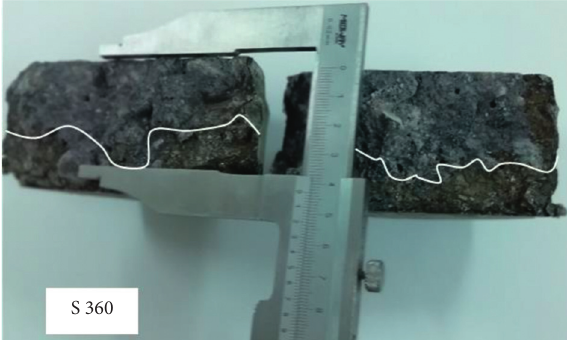
Figure 9: Chloride ions migration front for S 360.